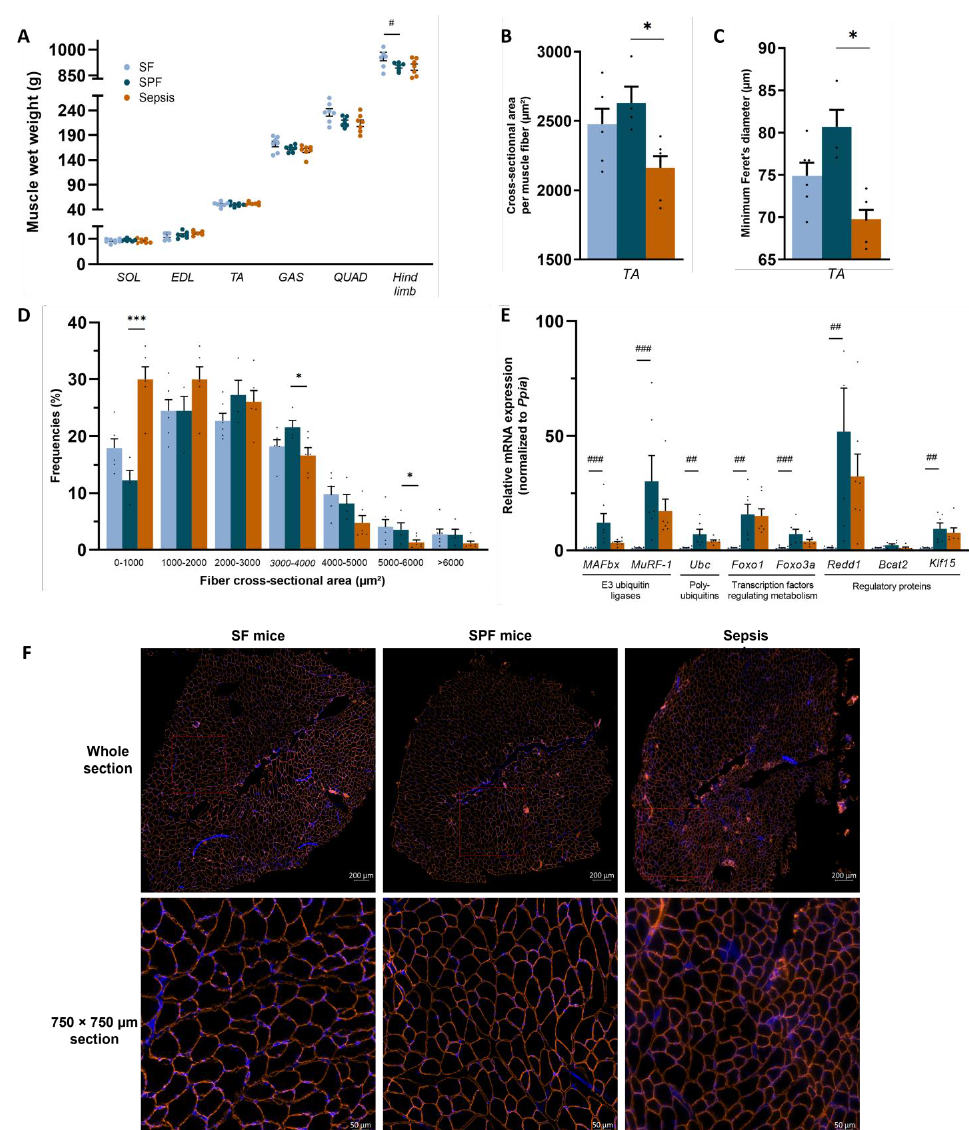
Figure 3. Sepsis-like energy deficit led to atrophy-related gene upregulation, but was not sufficient enough to induce muscle fiber atrophy. SOL , EDL , TA , GAS , and QUAD refer to soleus , extensor digitorum longus , tibialis anterior , gastrocnemius , and quadriceps , respectively, and the term “hind limb” refers to the sum of the SOL, EDL, TA, GAS, and QUAD of both limbs. ( A ) Wet weights of SOL , EDL , TA , GAS , and QUAD were not different between the groups, but the hind limb muscles decreased in the SPF group compared with the SF group and was similar to the Sepsis group. ( B , C ) TA cross-sectional area and minimum Feret’s diameter per muscle fiber of Sepsis mice were lower compared with SPF mice, but not different between SPF and SF mice. ( D ) Fiber area distribution of TA. ( E ) mRNA expression of the atrophy-related genes MAFBx , MuRF-1 , Ubc , Foxo1 , Foxo3a , Redd1 , and Klf15 were higher in the SPF group than the SF group and not different between the SPF and Sepsis groups. Bcat2 was not different between groups. ( F ) Representative images of whole-section (up) and magnification (down) cross-sectional area immunostaining by laminin α -2 in orange and DAPI in blue of SF (left), SPF (middle), and Sepsis (right) groups. Light-blue highlights the SF group (n = 6–8), dark-blue highlights the SPF group (n = 4–7), and orange highlights the Sepsis group (n = 6–7). Data are expressed as means with SEM and analyzed using a Kruskal–Wallis test with post hoc Dunn’s test. # SPF vs. SF and * Sepsis vs. SPF. * p < 0.05, *** p < 0.001, # p < 0.05, ## p < 0.01, ### p <